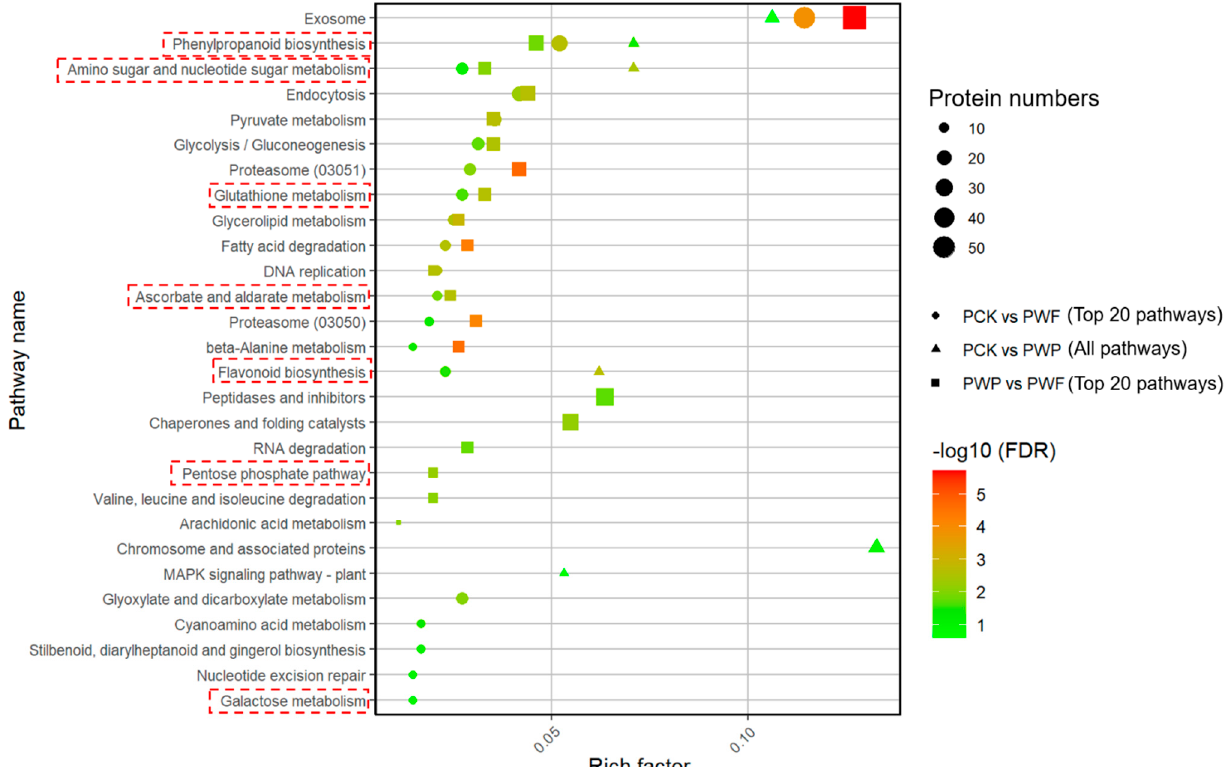
Figure 4. Functional enrichment analysis of differentially expressed proteins (DPs). The significantly enriched KEGG pathways of the DPs in threes group (including PCK vs. PWP, PWP vs. PWF, PCK vs. PWF). PCK, PWP, and PWF represent proteomic samples with withering times of 0 h, 12 h, and 30 h, respectively.